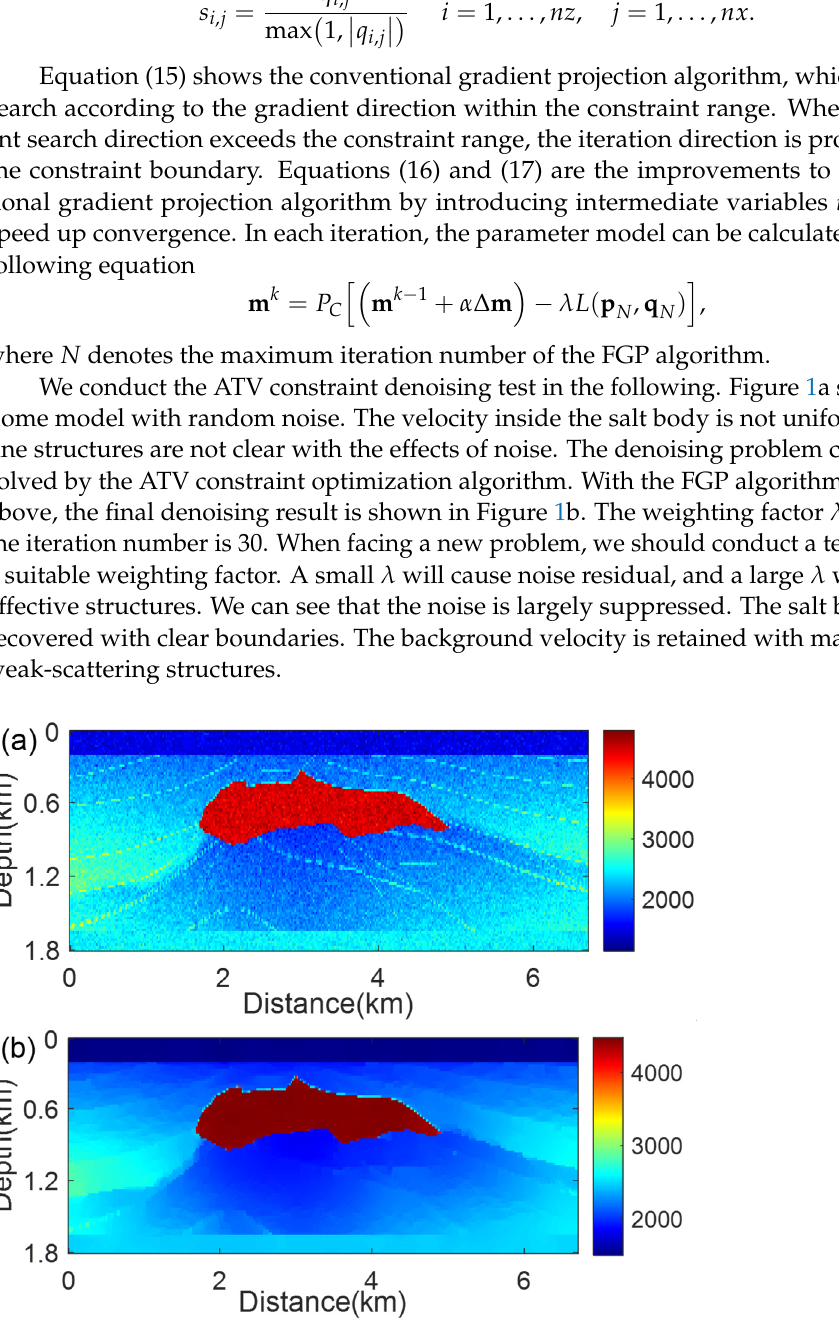
Figure 1. ATV constraint denoising test. ( a ) Salt velocity model with random noise; ( b ) ATV constraint denoising result.